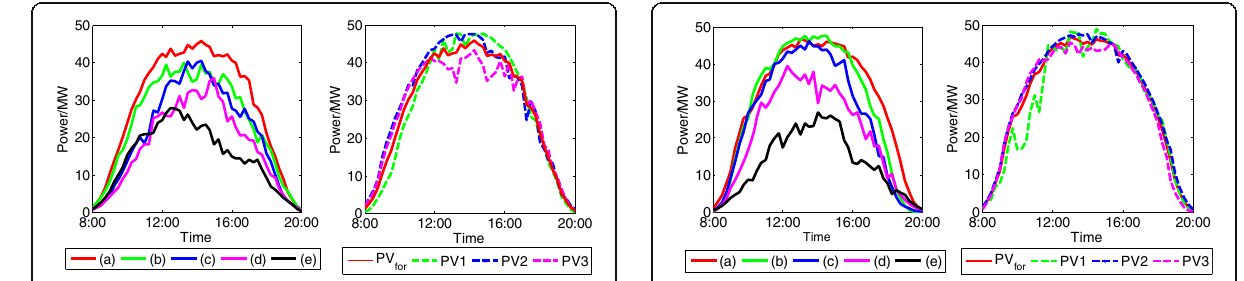
Fig. 6 Typical scenarios and the output curves of representative scenario in fall